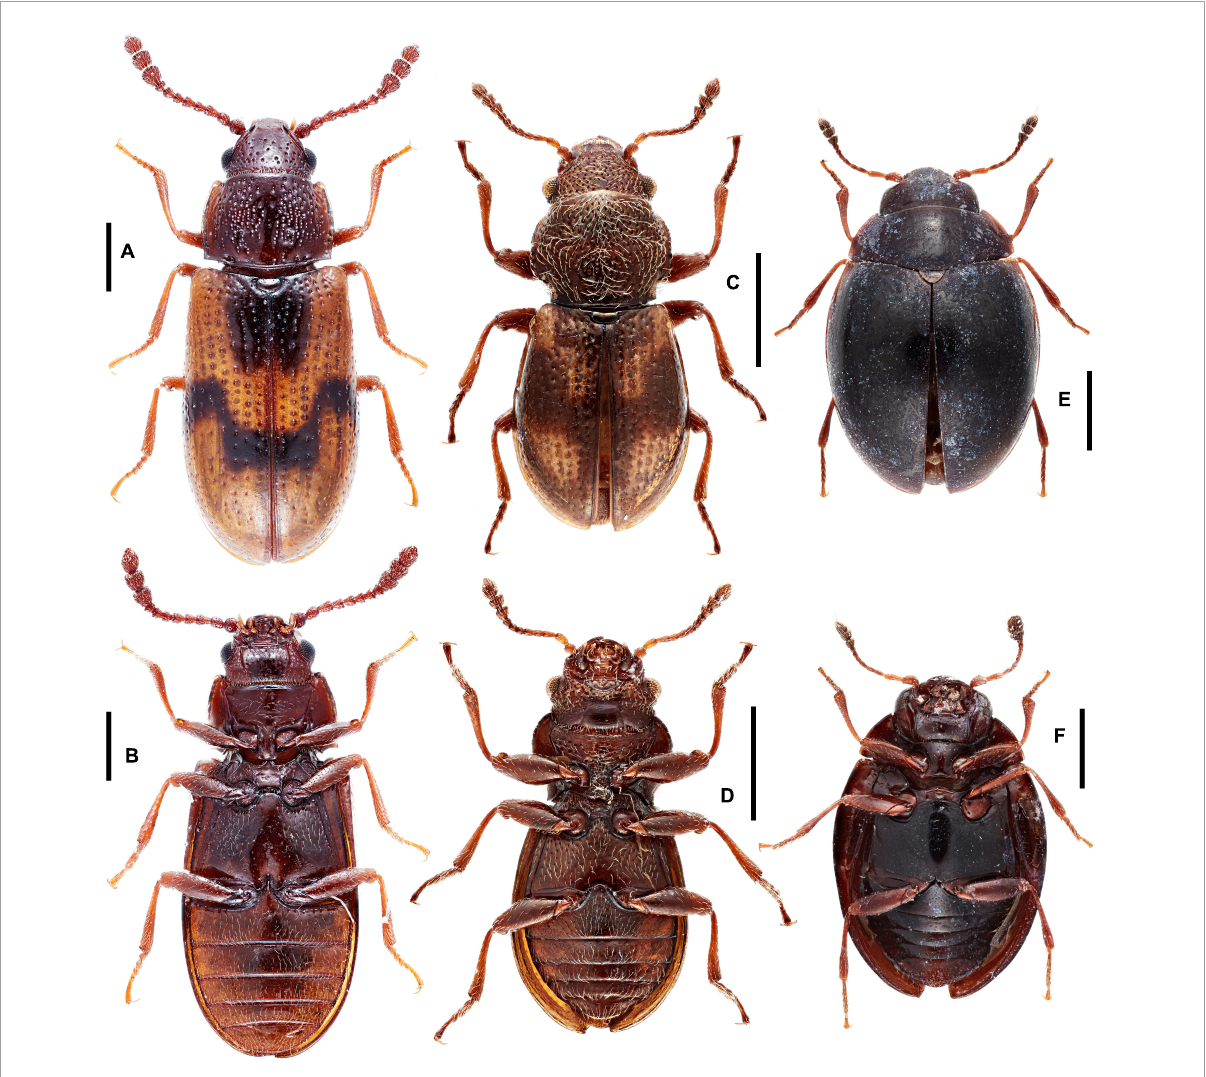
FIGURE6 Extant representatives of Lamingtoniidae, Tasmosalpingidae, and Cyclaxyridae. (A,B) Lamingtonium loebli Lawrence and Leschen. (C,D) Tasmosalpingus quadrispilotus Lea. (E,F) Cylaxyra politula Broun. Scale bar: 500 µ